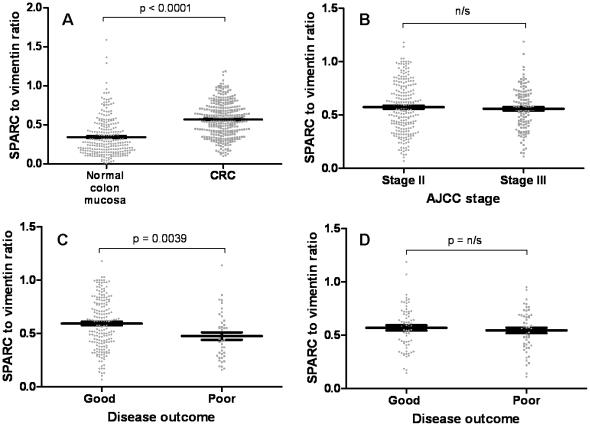
SPARC expression in stage II and III CRC using TMAs.(A) The SPARC to vimentin ratio was significantly greater in CRC tissue compared to normal colonic tissue. (B) No difference in SPARC expression was observed between stage II and III CRC. (C) SPARC was significantly greater in patients with a good disease outcome in stage II CRC, but not in (D) stage III CRC. Each dot represents one patient and the bars represent the median value ± SEM.